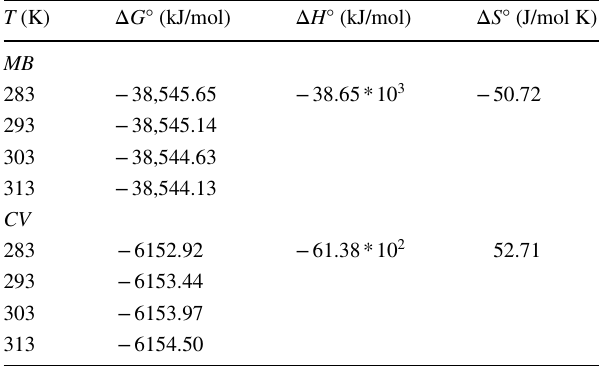
Table 3 Thermodynamic data for the adsorption of MB and CV onto